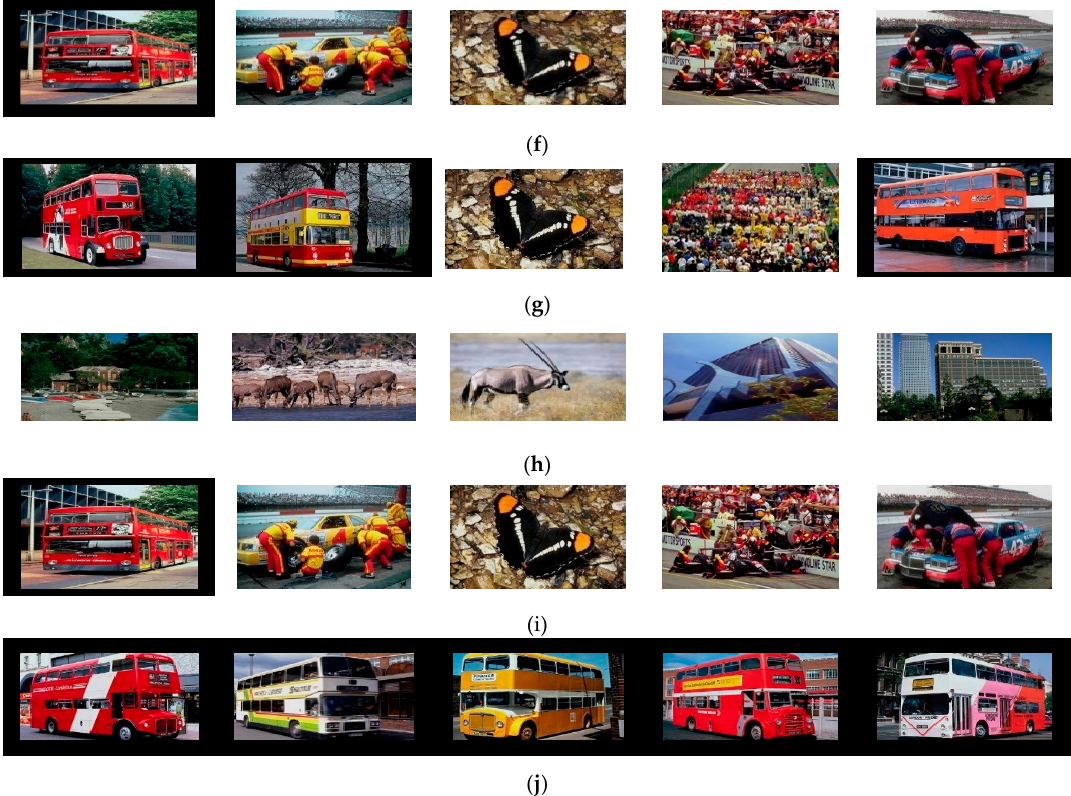
Figure 3. Sample query 2 and its corresponding retrieval result with respect to all considered approaches. ( a ) The query images. ( b ) Results obtained using the method in [17] with color weight = 0.1 and texture weight = 0.9. ( c ) Results obtained using the Image Grouper [19]. ( d ) Results obtained using the method in [22] with color weight = 0.5 and texture weight = 0.5. ( e ) Results obtained using the method in [22]. ( f ) Results obtained using the method in [23]. ( g ) Results obtained using the method in [26]. ( h ) Results obtained using the method in [27]. ( i ) Results obtained using the method in [29]. ( j ) Results obtained using the proposed method.